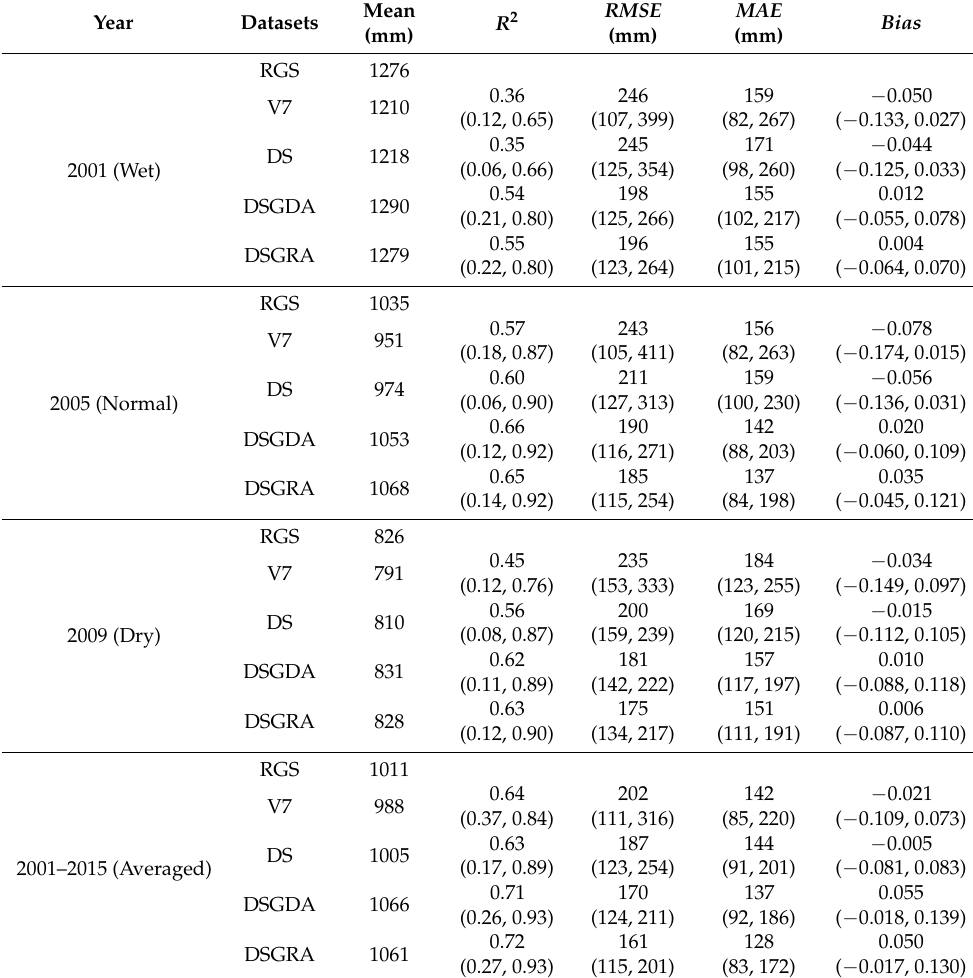
Figure 10. Box plots of downscaled and calibrated annual precipitation for three reference years and the entire time period. Table 3. Statistics of validation results using 19 validation RGS on an annual scale for three reference years and the entire time period (95% confidence intervals are in